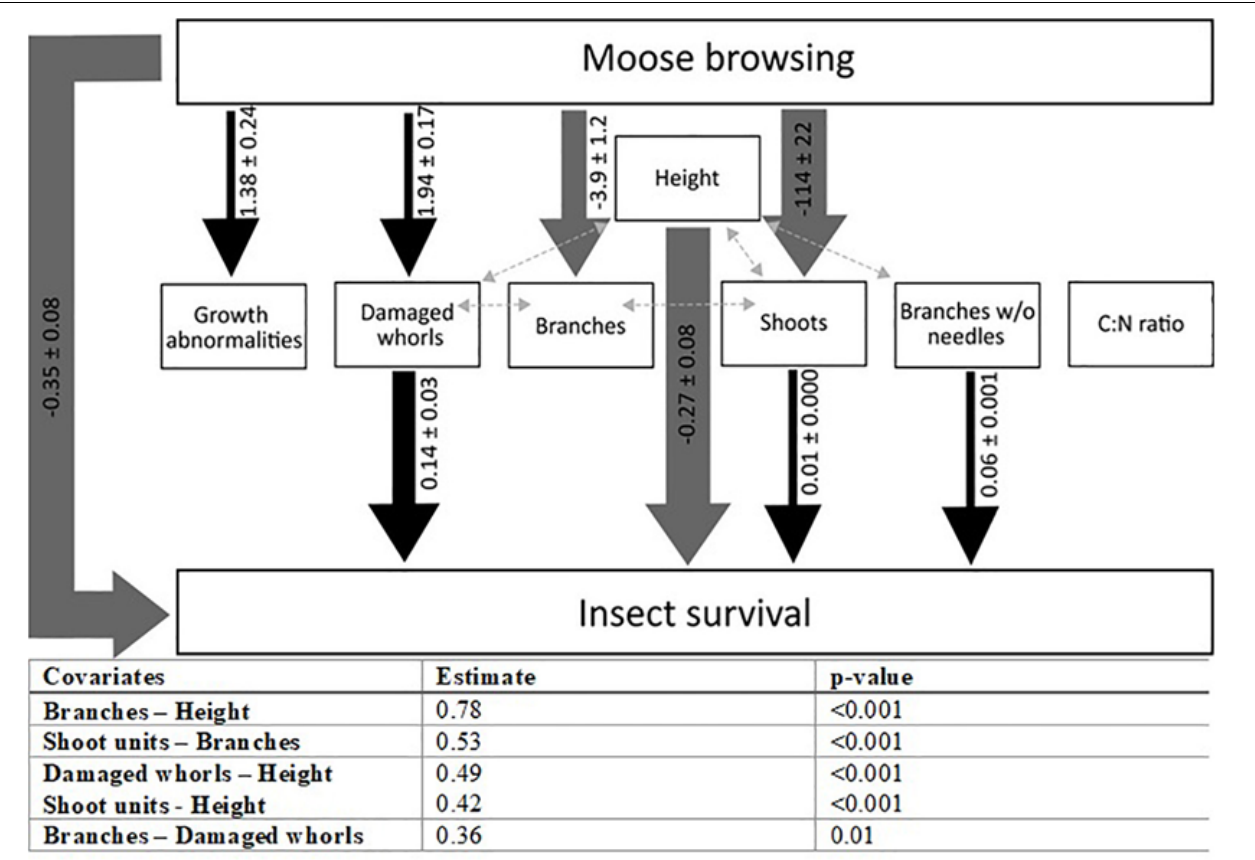
FIGURE 4 | Illustration of the final structural equation model showing significant direct and indirect effects of moose browsing on insect survival as well as co-variances. Significant positive and negative relationships are shown with black and gray arrows, respectively. Path coefficients and standard error are indicated on or beside the arrows, and the thickness of the arrow correspond to the magnitude of those coefficients. Light gray dashed double-headed arrows denote significant co-variances between variables. The level of co-variance per combination is provided in the box below. Summary statistics for the initial and final model is provided in Supplementary Table 5 and marginal and conditional R 2 -values are provided in Supplementary Table 6